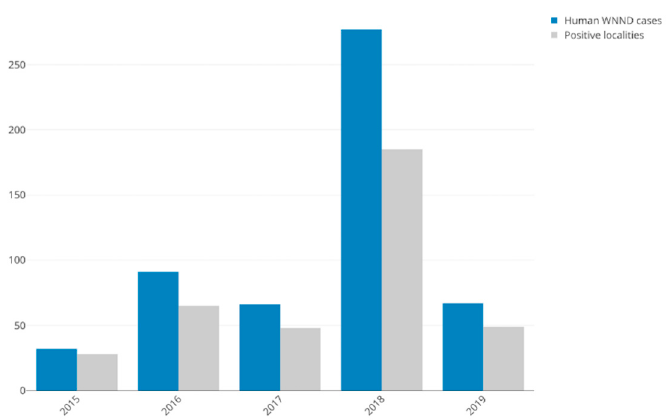
Figure 1. Annual number of human West Nile neuroinvasive disease (WNND) cases and number of positive localities. Table 1. Number of human WNND cases, positive localities, and trend overview.